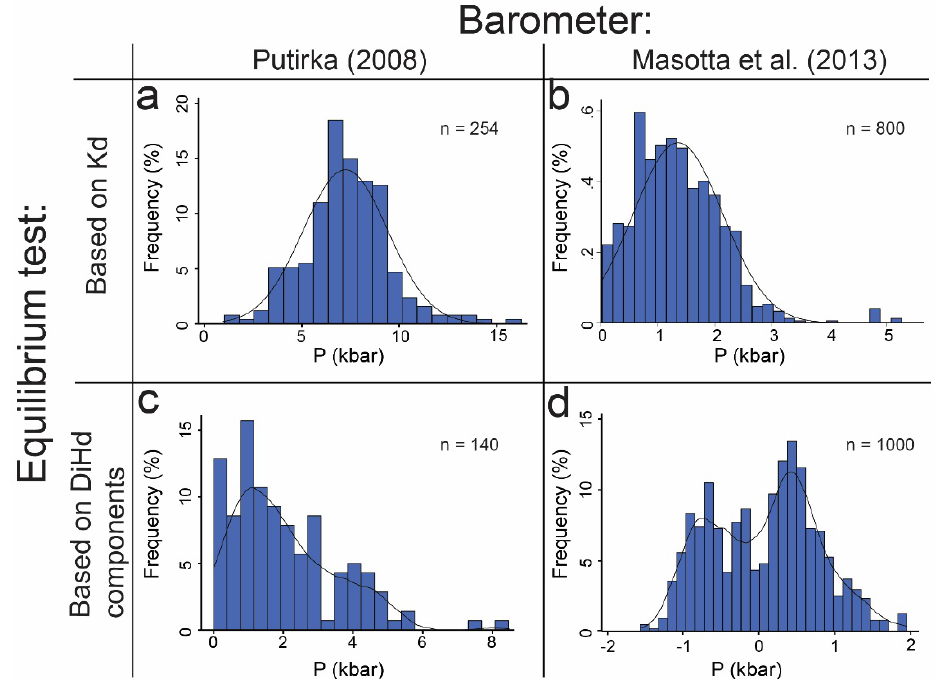
Figure 13. Comparison of the estimated pressures (kbar) obtained through the various methods combining equilibrium tests and geobarometers; ( a ) frequency (%) histogram of pressure estimates obtained through the equation 32c of the Putirka [13] geobarometer applied to clinopyroxene-melt couples whose equilibrium has been verified with equilibrium test 1; ( b ) frequency (%) histogram of pressure estimates obtained through the equation Palk of the Masotta et al. [30] geobarometer applied to clinopyroxene-melt couples whose equilibrium has been verified with equilibrium test 1; ( c ) frequency (%) histogram of pressure estimates obtained through the equation 32c of the Putirka [13] geobarometer applied to clinopyroxene-melt couples whose equilibrium has been verified with equilibrium test 2; ( d ) frequency (%) histogram of pressure estimates obtained through the equation Palk of the Masotta et al. [30] geobarometer applied to clinopyroxene-melt couples whose equilib- rium has been verified with equilibrium test 2.